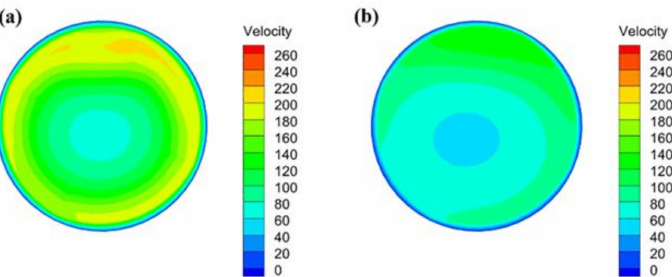
Figure 4. Velocity distribution on the cross sections A ( a ) and B ( b ) of the combustion zone.